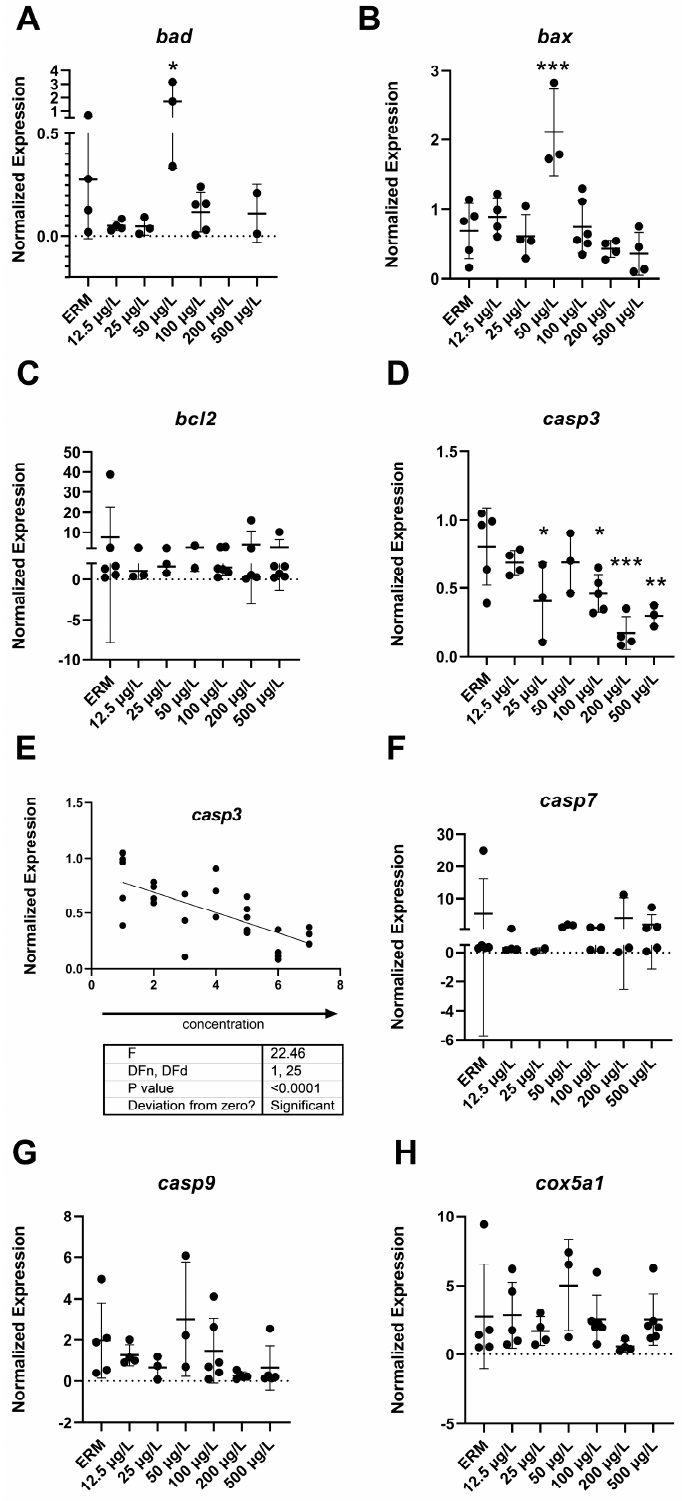
Figure 4. Transcript levels of apoptosis: ( A ) Bcl2 associated agonist of cell death, bad ; ( B ) Bcl2 associated x, apoptosis regulator, bax ; ( C ) Bcl2 apoptosis regulator, bcl2 ; ( D ) Caspase 3a, casp3a ( E ) Linear regression of caspase 3a, casp3a ( F ); Caspase 7, casp7 ( G ); Caspase 9, casp9 ( H ); Cytochrome c oxidase subunit 5Aa, cox5a1 in 7 dpf zebrafish larvae exposed to sulfamethoxazole. Data represented as mean ( ± SD). One-way ANOVA followed by Dunnett’s post-hoc test, * p ≤ 0.05, ** p ≤ 0.01, *** p ≤ 0.001, n = 3–5 biological